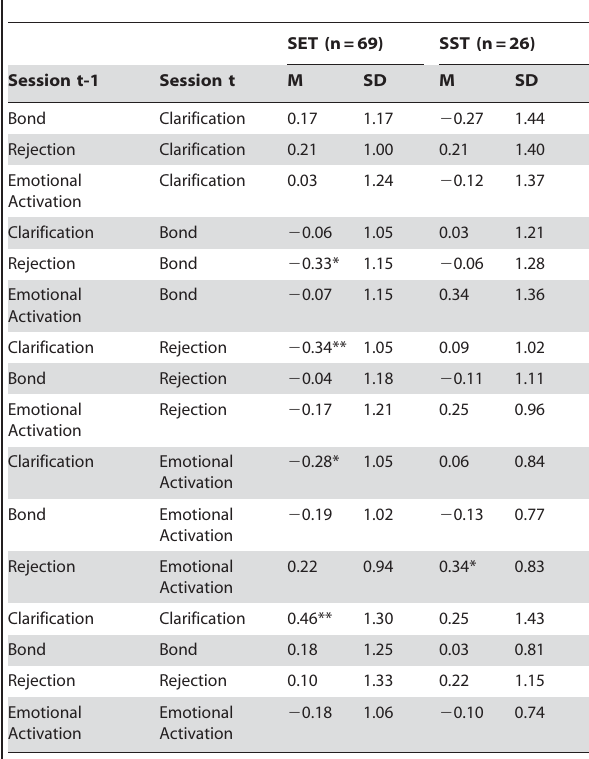
Table 2. Time-lagged